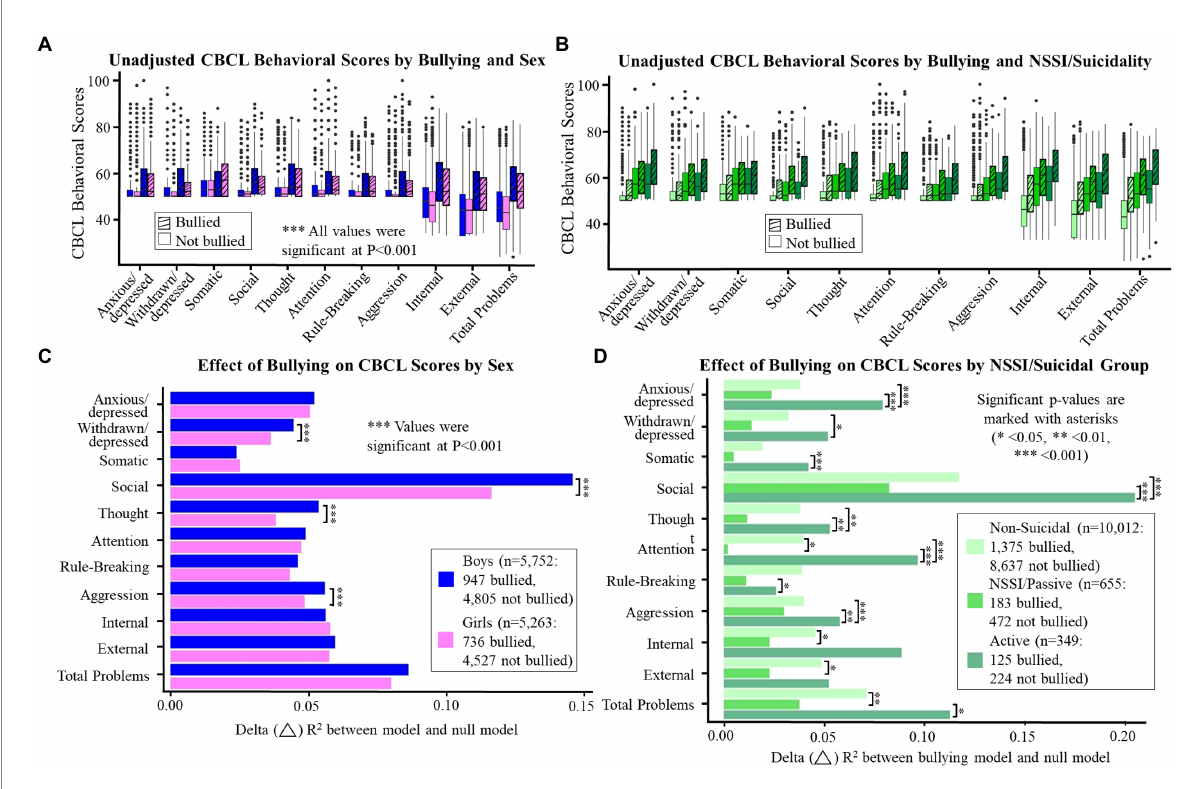
FIGURE 3 (A–D) display the unadjusted mean t -scores for each CBCL domain by reported bullying (A,B) and the effect sizes of the impact of bullying on CBCL domain scores (C,D) by sex (A,C) or NSSI/suicidality group (B,D) . Significant p -values are marked with asterisks (* <0.05, ** <0.01, ***